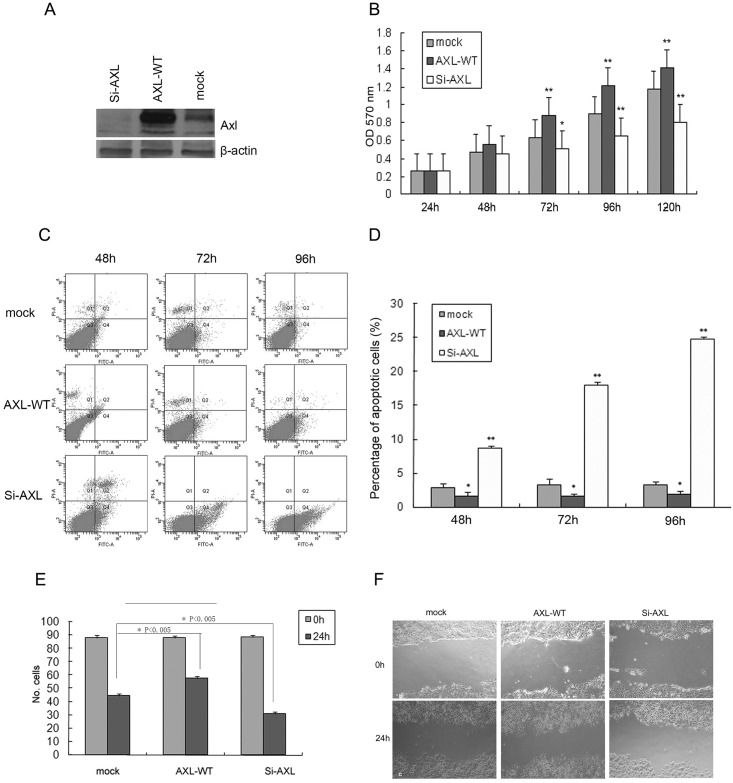
Effects of AXL expression on cell growth and invasiveness of SMMC-7721.A: Western blot analysis of cell lysate expressing the control vector (mock), the wild-type AXL (AXL-WT, stable transfection), and RNAi AXL (Si-AXL, transient transfection after 72 hours). B: Cell growth curve of cells transfected with constructs as indicated by MTT assay. C, D: Representative plots of flow cytometry and statistical results of cell apoptosis of cells transfected by constructs as indicated by propidium iodide and annexin V-FITC staining. Bars, ±SD. *, P<0.05 versus mock, **, P<0.001 versus mock. E: Statistical results of cells transfected with constructs as indicated in transwell assay. *, P<0.05 versus mock, **, P<0.001 versus mock. F: Representative image of cells transfected with constructs as indicated in the wound healing assay. Mock: control vector; AXL-WT: the wild-type AXL; si-Axl: transient transfection after 72 hours.